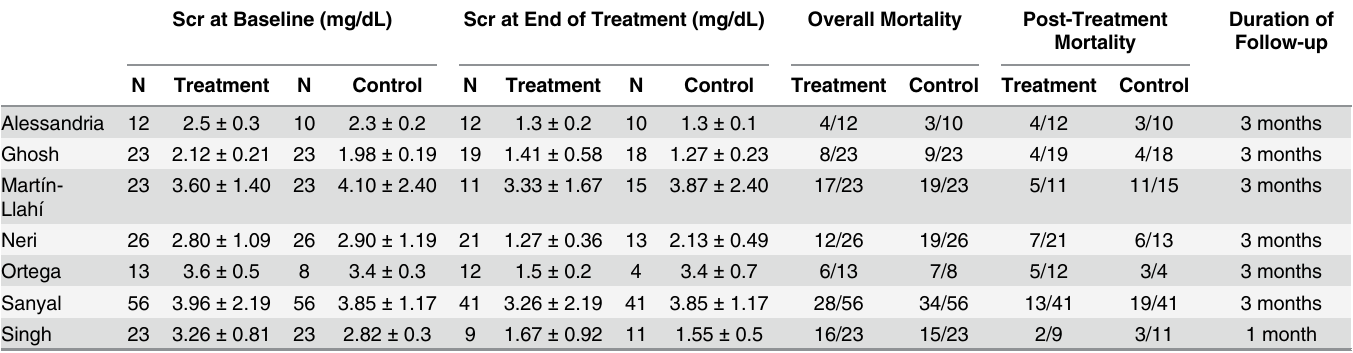
Table 2. Trial Outcomes.